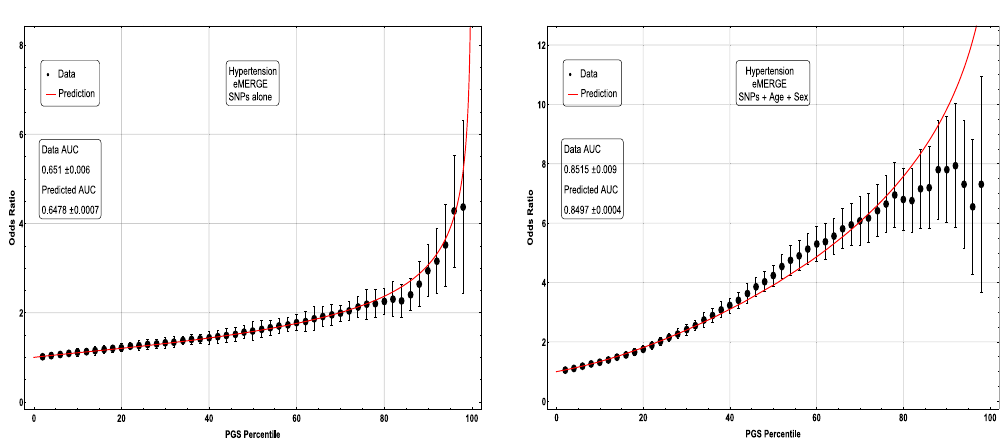
Figure 10. Odds ratio between upper percentile in PGS and total population prevalence in eMERGE for Hypertension with and without using age and sex as covariates.